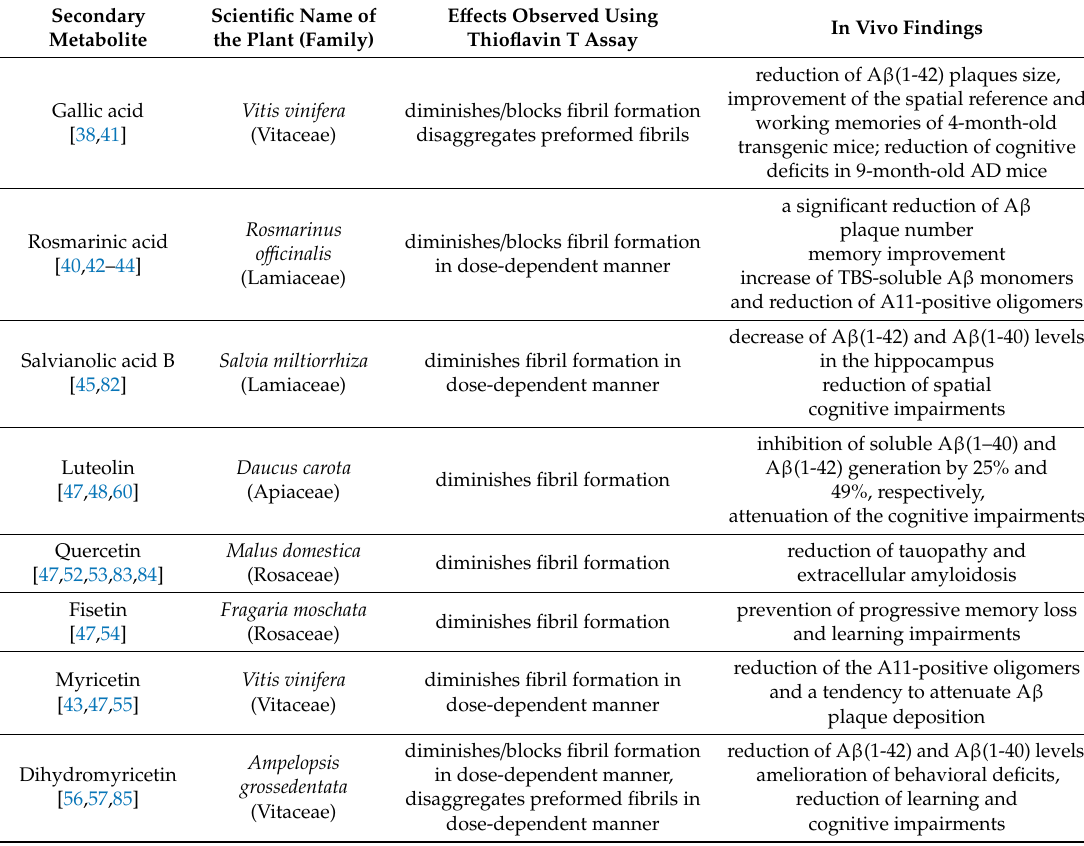
aggregation: plant family, in vitro, and in vivo effects .